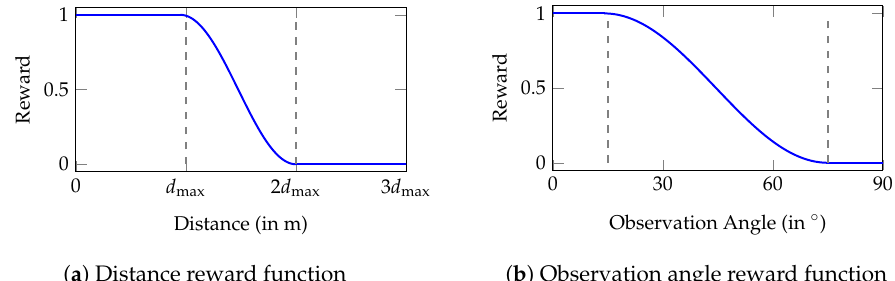
Figure 4. Heuristics for individual viewpoint candidates considering distances and observation angles toward an object point. ( a ) Rewards considering the distance between viewpoint and object points regarding the maximum distance d required to achieve a user-specified ground sampling distance (GSD). ( b ) Rewards based on observation angles defining maximum rewards for fronto-parallel views (here: up to 15 ◦ ) and zero rewards for more than 75 ◦